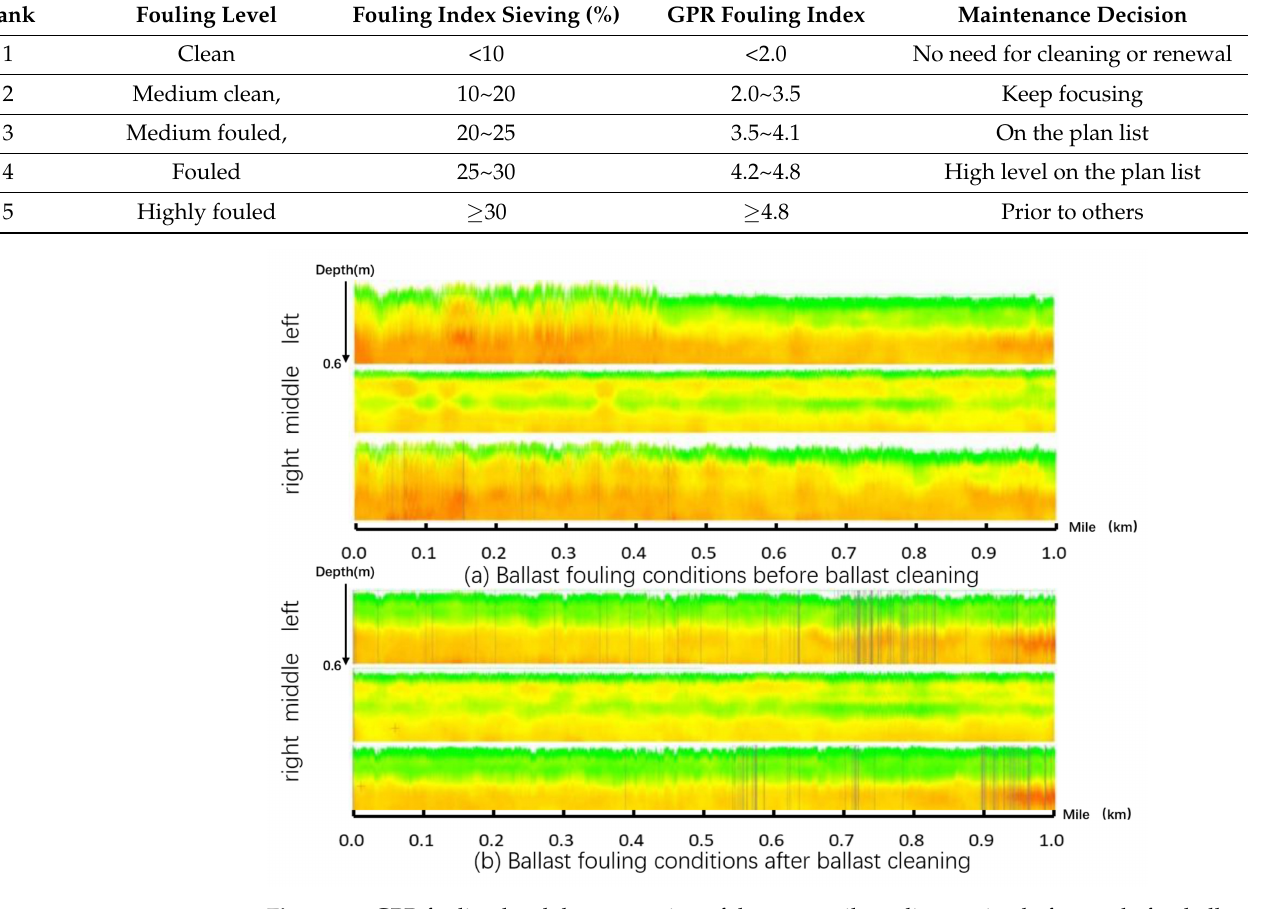
Figure 17. GPR fouling level demonstration of the same railway line section before and after ballast cleaning (figure modified after